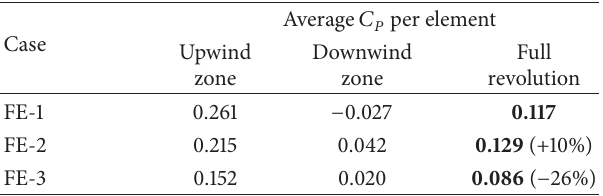
Table 3: Average performance coefficient per element on one revolution, when different numbers of elements are present in the